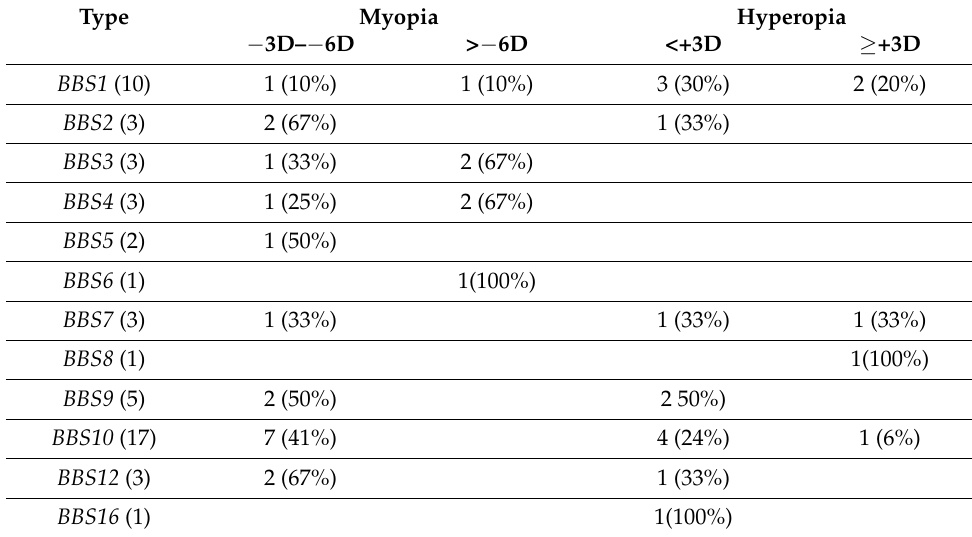
Figure 1. Demographics of the 61 BBS patients. ( A ): Age of the patients, for male and female separately. ( B ): Decimal visual acuity of the left and right eyes plotted against age. ( C ): Frequency of BBS genes carrying biallelic mutations in the patients of this study. ( D ): Common variants presented as percentage of total allele counts. BBS10 c.271dup;p.C91Lfs*5 (21%) and BBS1 c.1169T>G;p.M390R (18%) are most common, but also other variants with up to 5 alleles were observed recurrently. Table 1. Spherical equivalent (dpt) of the right eye. Number of patients and % of cases for each genetic subgroup.